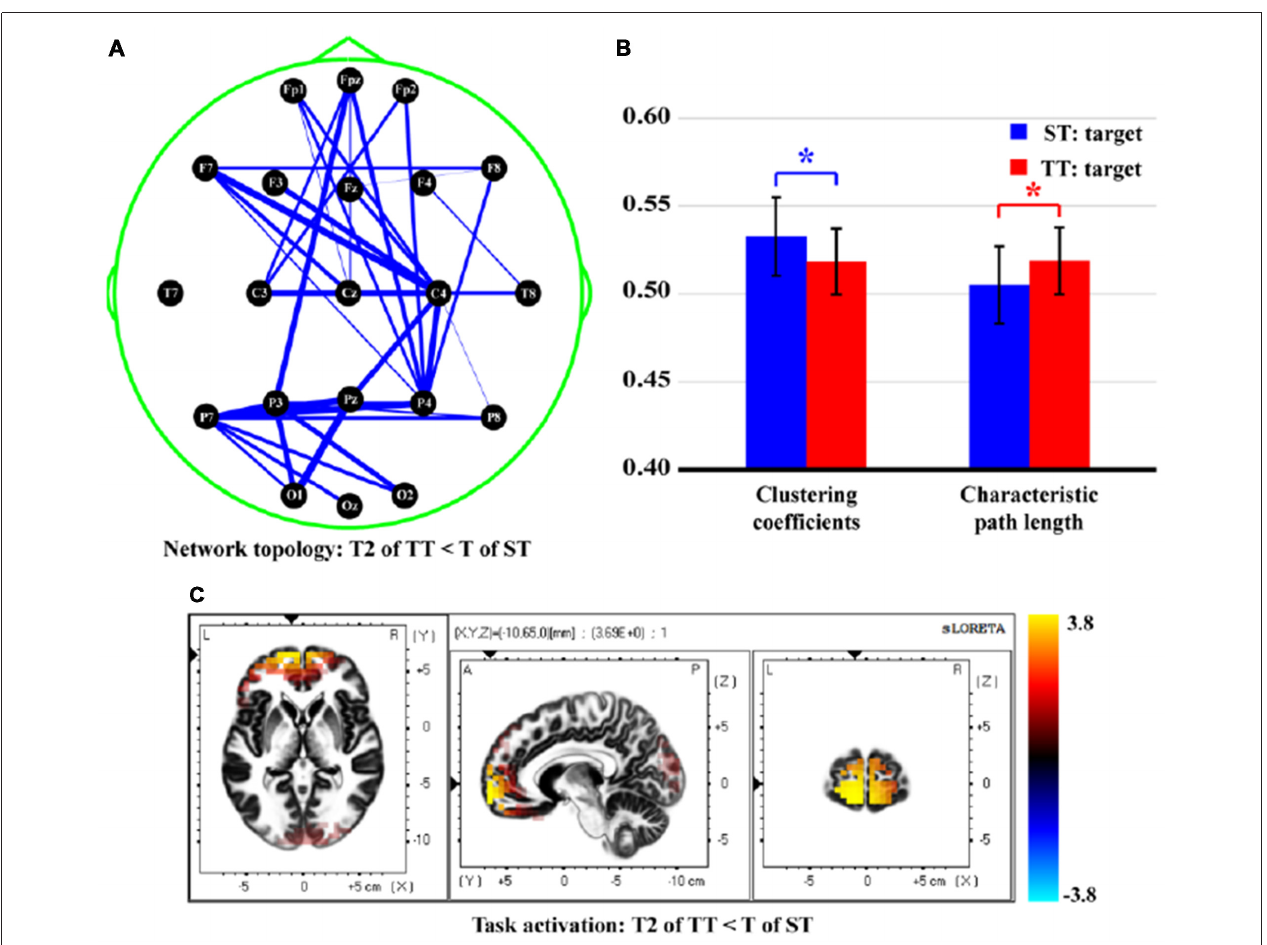
FIGURE 6 | Differences of network topology, properties, and task activation between T in ST and T2 in TT. (A) Network topology. (B) Network properties. (C) Task activation. In (A) , the blue solid lines denote the weaker network edges of T2 in TT compared to that of T in ST; the line widths denote the quantitative differences of edge strengths between two conditions. In (B) , the red and blue bars denote the network properties corresponding to T2 in TT and T in ST, respectively. ∗ Indicates p < 0.05. Error bars denote the standard deviations of network properties among 22 subjects. Values are the means and standard deviations (Mean ± SD) of network